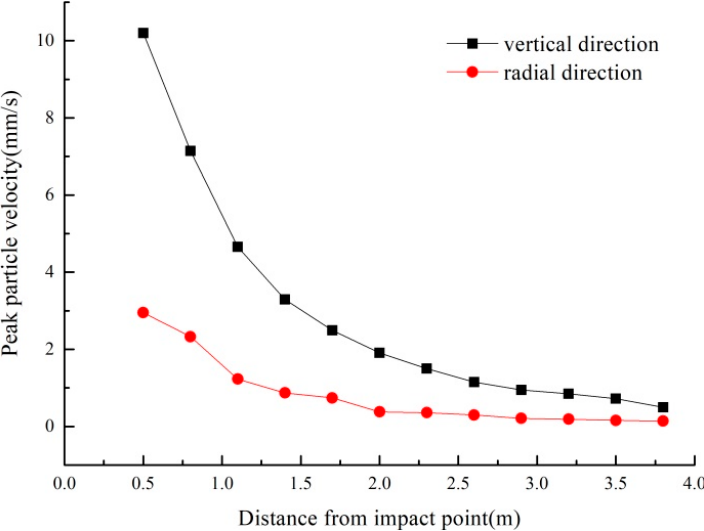
Figure 3. Attenuation of vertical and radial peak particle velocity with distance on concrete surface.